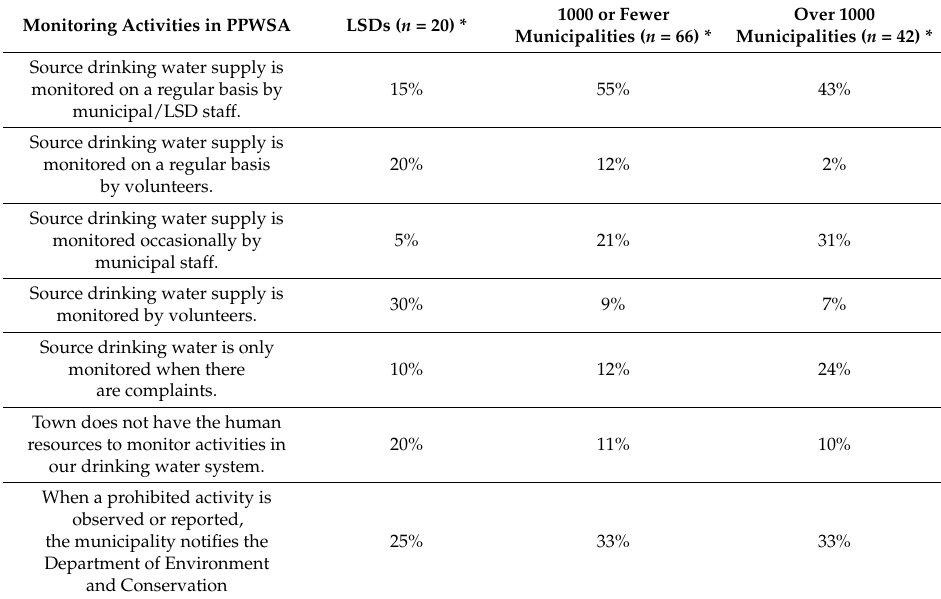
Table 2. Compliance with source water monitoring